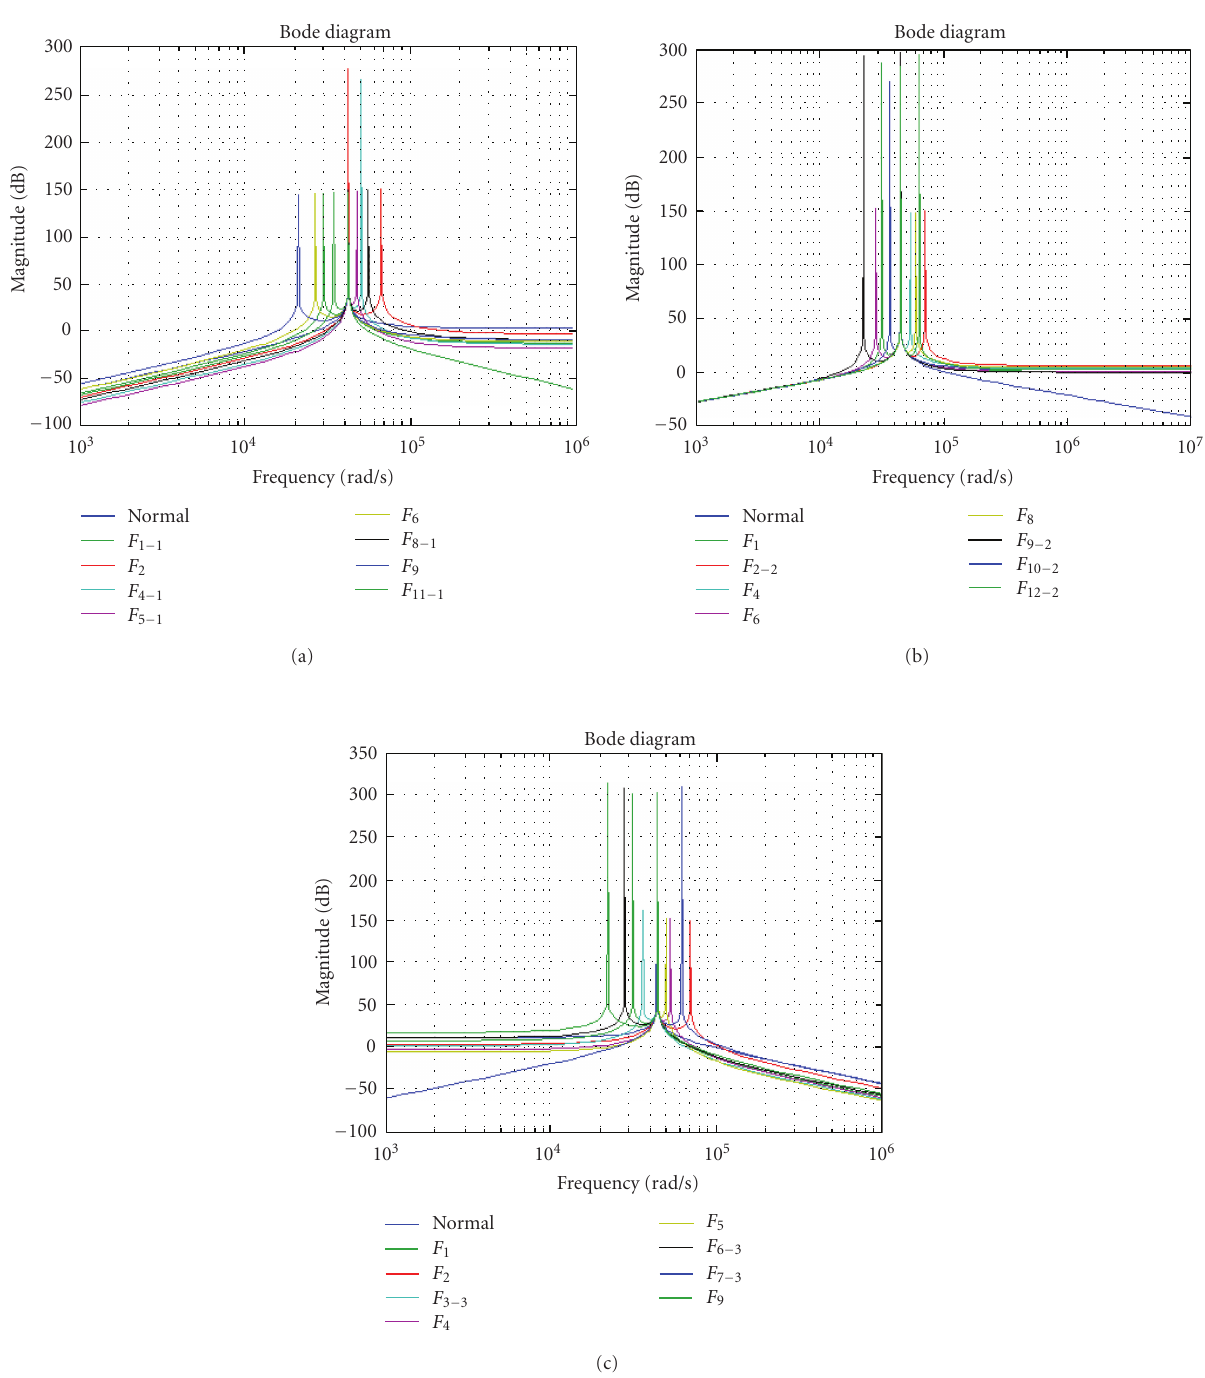
Figure 10: Response of the single faults (a) at node 1, (b) at node 2, and (c) at node